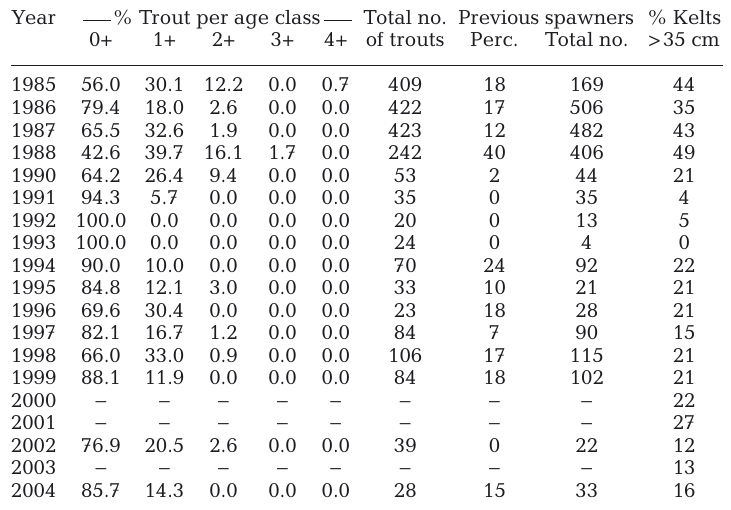
Table 4. Percentage of sea trout Salmo trutta in each sea age class, percent- age previous spawned sea trout and percentage sea trout kelts >35